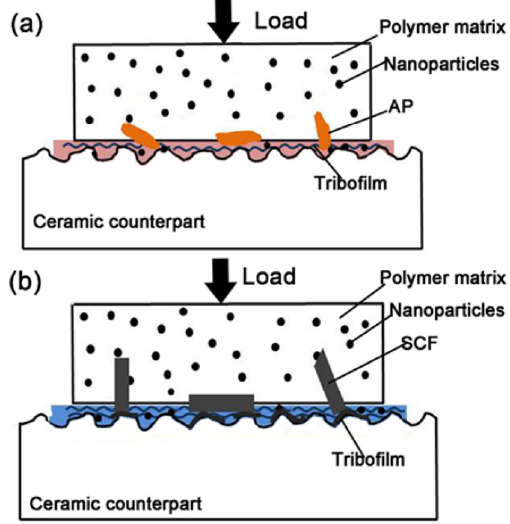
Fig. 15 Schematic diagrams of interfacial interactions between (a) AP-reinforced PI composites and (b) SCF-reinforced PI com- posites and Al 2 O 3 counterpart.